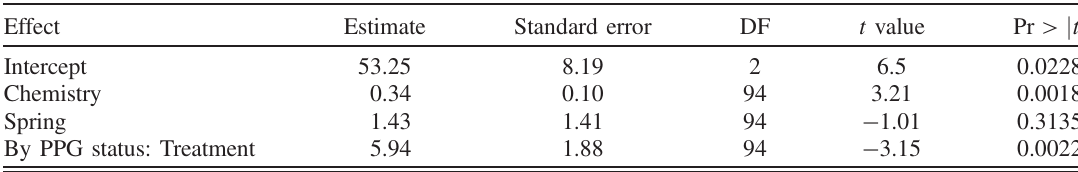
TABLE IX. Stability model results for semester physics performance by year for SY 2014 – 2015. Note that the intercept represents the estimate for the control group in the fall.